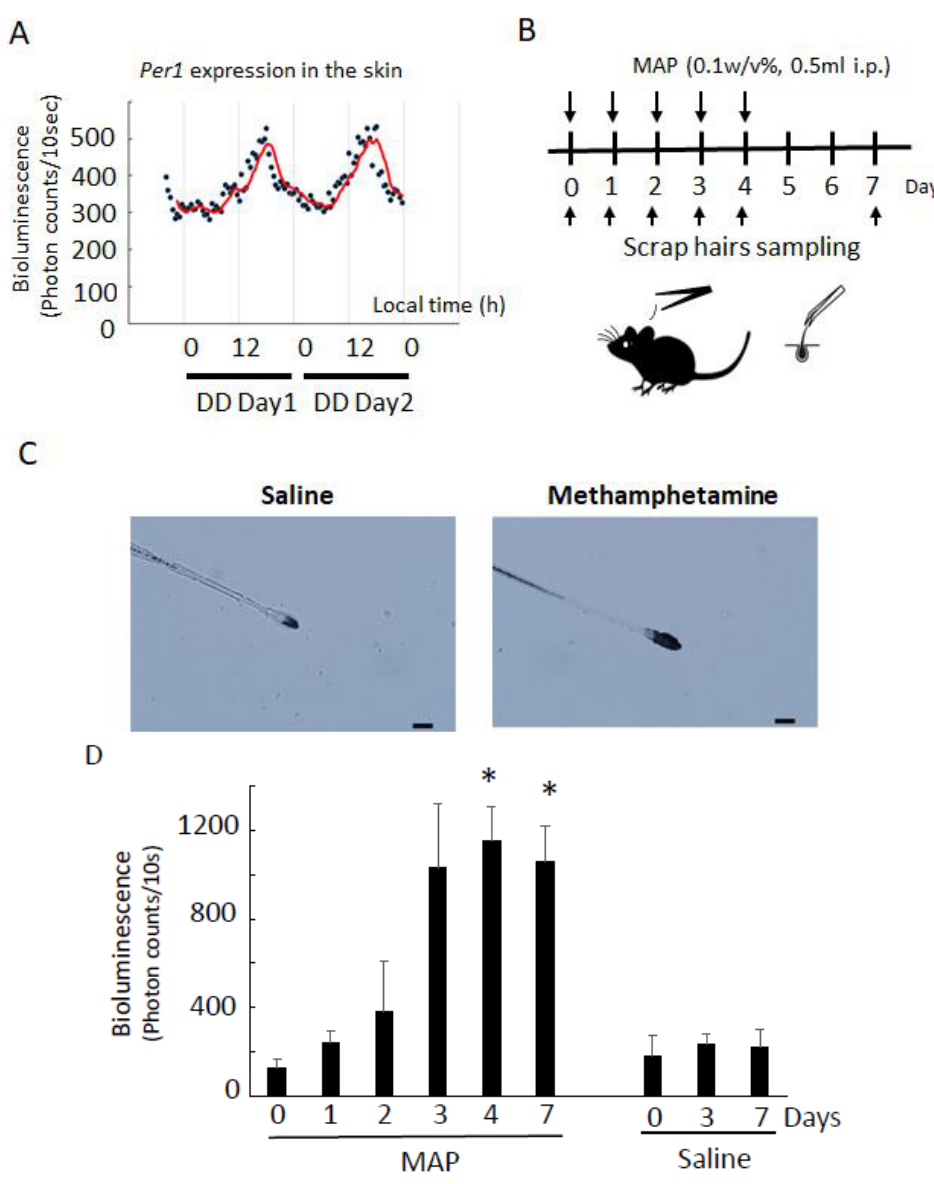
Figure 2. MAP-induced Per1 gene expression in scalp hairs. ( A ) Per1 bioluminescence (photon counts/10 s) of the skin in a freely moving Per1-luc mouse with a TCS [15]. The TCS was implanted under the skin of the Per1-luc mouse. Bioluminescence was measured from DD day 1. Photons emitted by the skin cells of freely moving mice were integrated over 10 s intervals and averaged for 30 min. The red line is the trend line. ( B ) Schematic figure of scalp hair sampling and MAP injections at ZT3. Day 0 indicates the start day of MAP injections. Sampling of the scalp hairs was performed just before MAP injections. Mouse scalp hairs were isolated by forceps and incubated in PicaGene cell culture reagent until the analysis using a micro-PMT system. ( C ) Expression of Per1 in scalp hair. The hairs were sampled at ZT3 on day 7. The photos indicate the immunostaining with LUC polyclonal antibody. The scale bar is 200 µ m. ( D ) MAP-induced Per1 gene expression in scalp hair after daily injection of MAP. Bioluminescence was measured every 10 s using a micro-PMT system [13]. The supply voltage was set to 800 V in order to obtain the bioluminescence. Statistical significance was determined by one-way ANOVA followed by Dunnett’s test (n = 4 animals) (* p < 0.05 vs. day 0). The day 0 sample was collected just before MAP